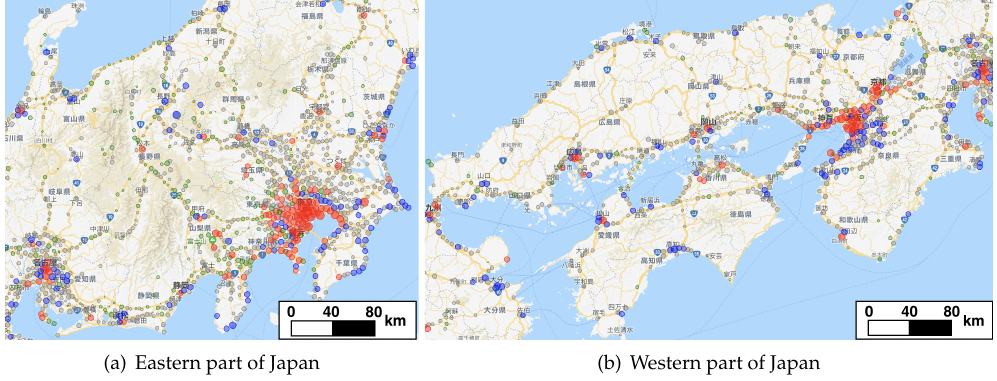
Figure 4. Spatial distribution of locations in each group: Red points are locations with top-20% attractiveness and top-20% originality. Blue points are locations with top-20% attractiveness and bottom-80% originality. Green points are locations with bottom-80% attractiveness and top-20%